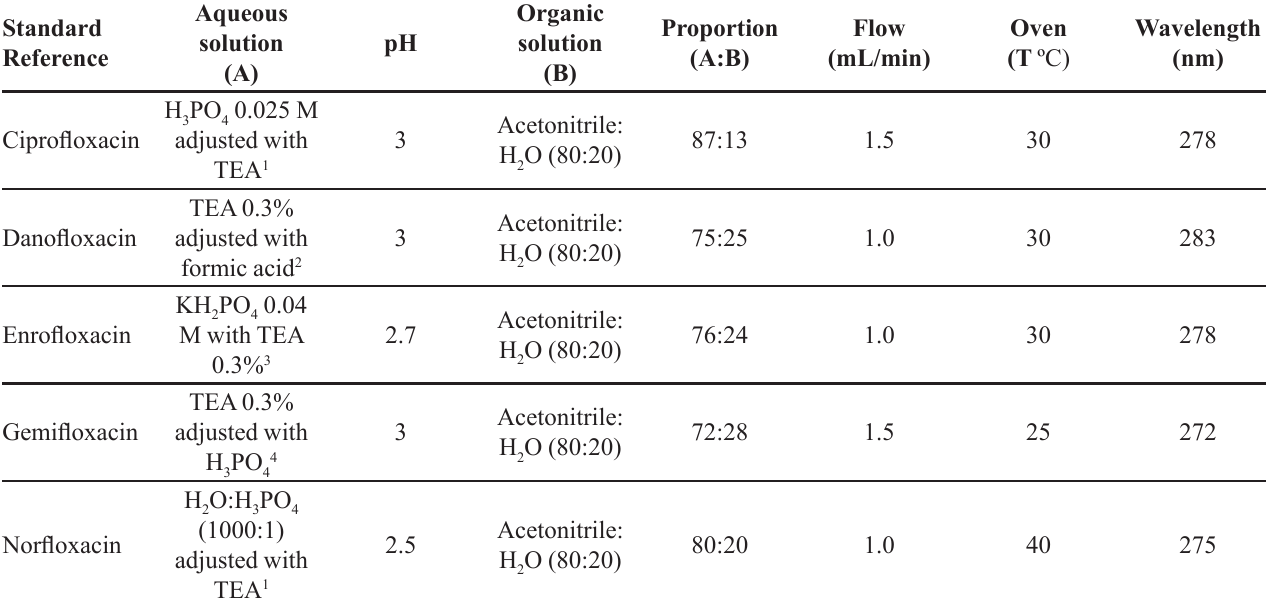
TABLE I - Chromatography conditions for the analysis of the products of forced degradation tests Standard Reference